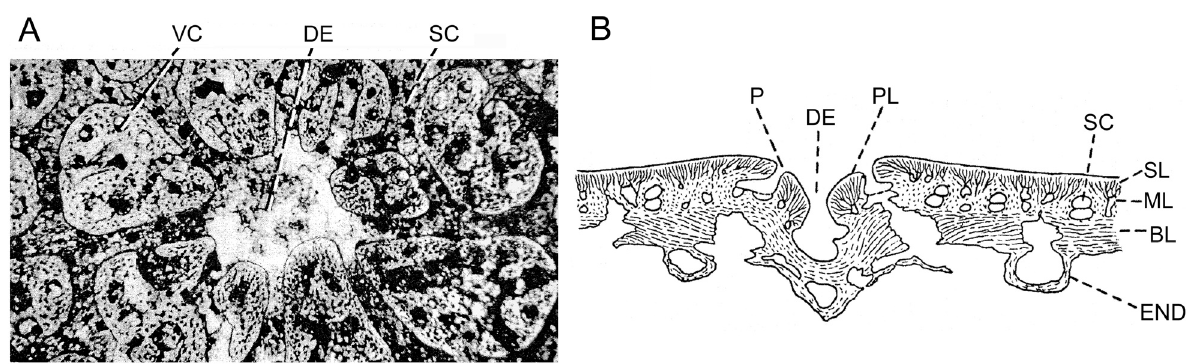
Fig. 8. Tremataspis mammillata Patten. A , image taken in horizontal view (Denison 1947, pl. 3, fig. 3), and B , cross-section of the shield (Denison 1947, fig. 9B).